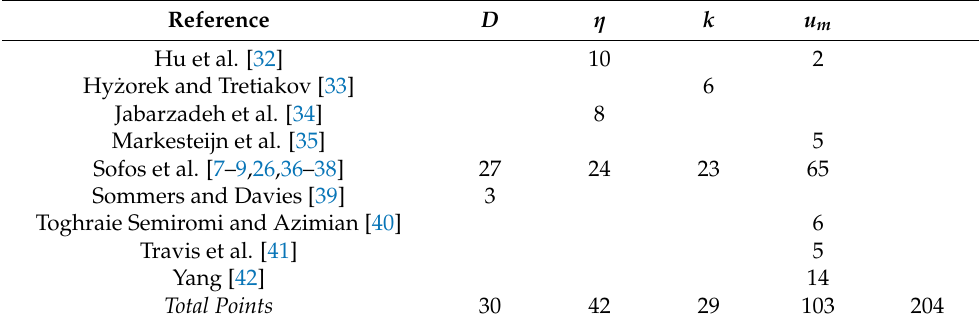
Table 1. Dataset sources and number of points incorporated.